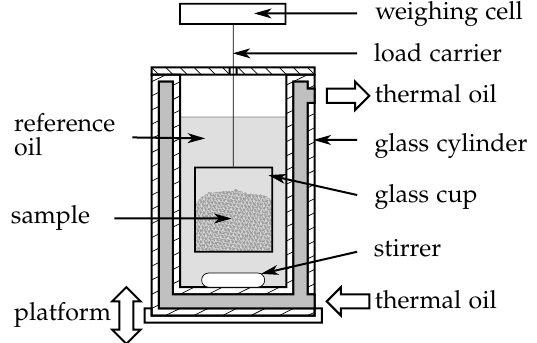
Figure 4: Sketch of the IMETER setup for density measure- Figure 2. Sketch of the IMETER setup for density ments.